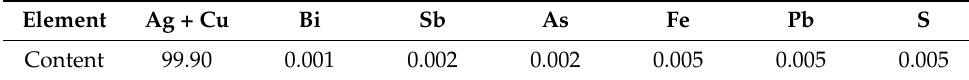
Table 1. Chemical compositions of T2 pure copper